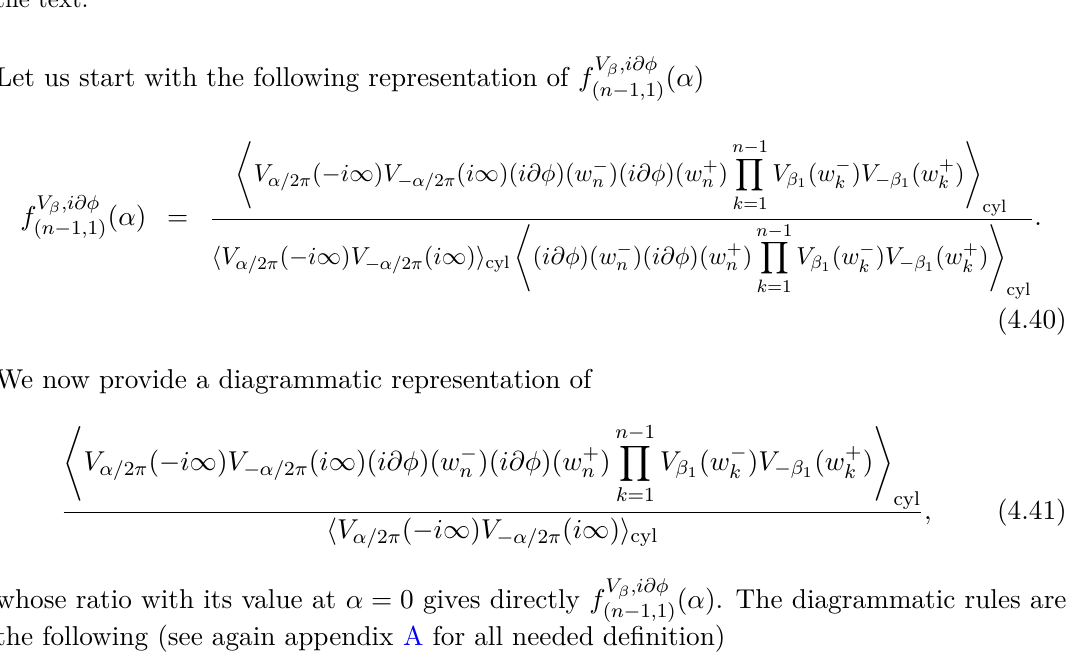
( α ) and f i∂φ, 1 ( α ) (left/right panels respectively) as func- Figure 5 . The universal functions f i∂φ, 1 (1 , 1) (1 , 2) tions of α for different values of x ( x = 1 / 10 , 1 / 4 , 1 / 2 ). The agreement with numerical data for the XX chain at half-filling, is good for small α but it worsens as α gets closer to ± π , as discussed in the